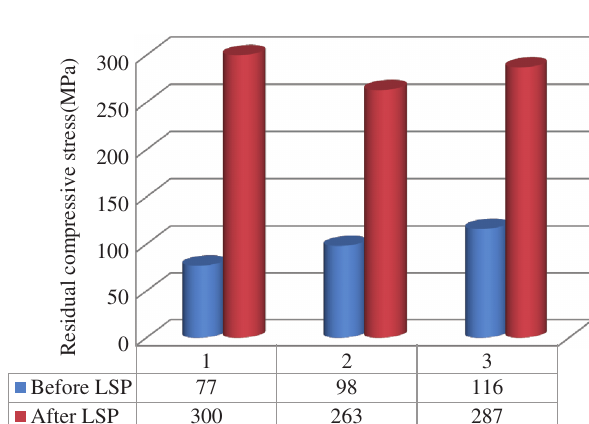
Figure 5: Residual compressive stress on material surface before and after LSP.